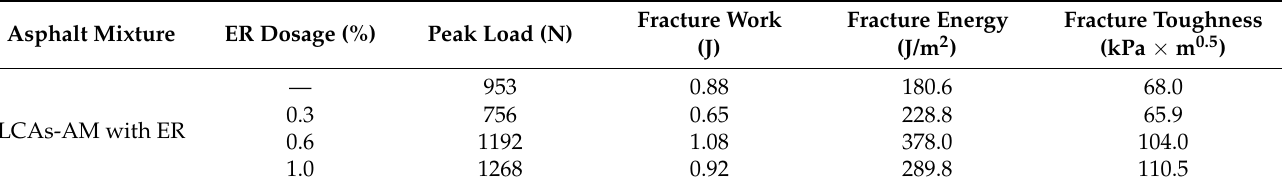
Table 12. Results of repeated SCB tests of